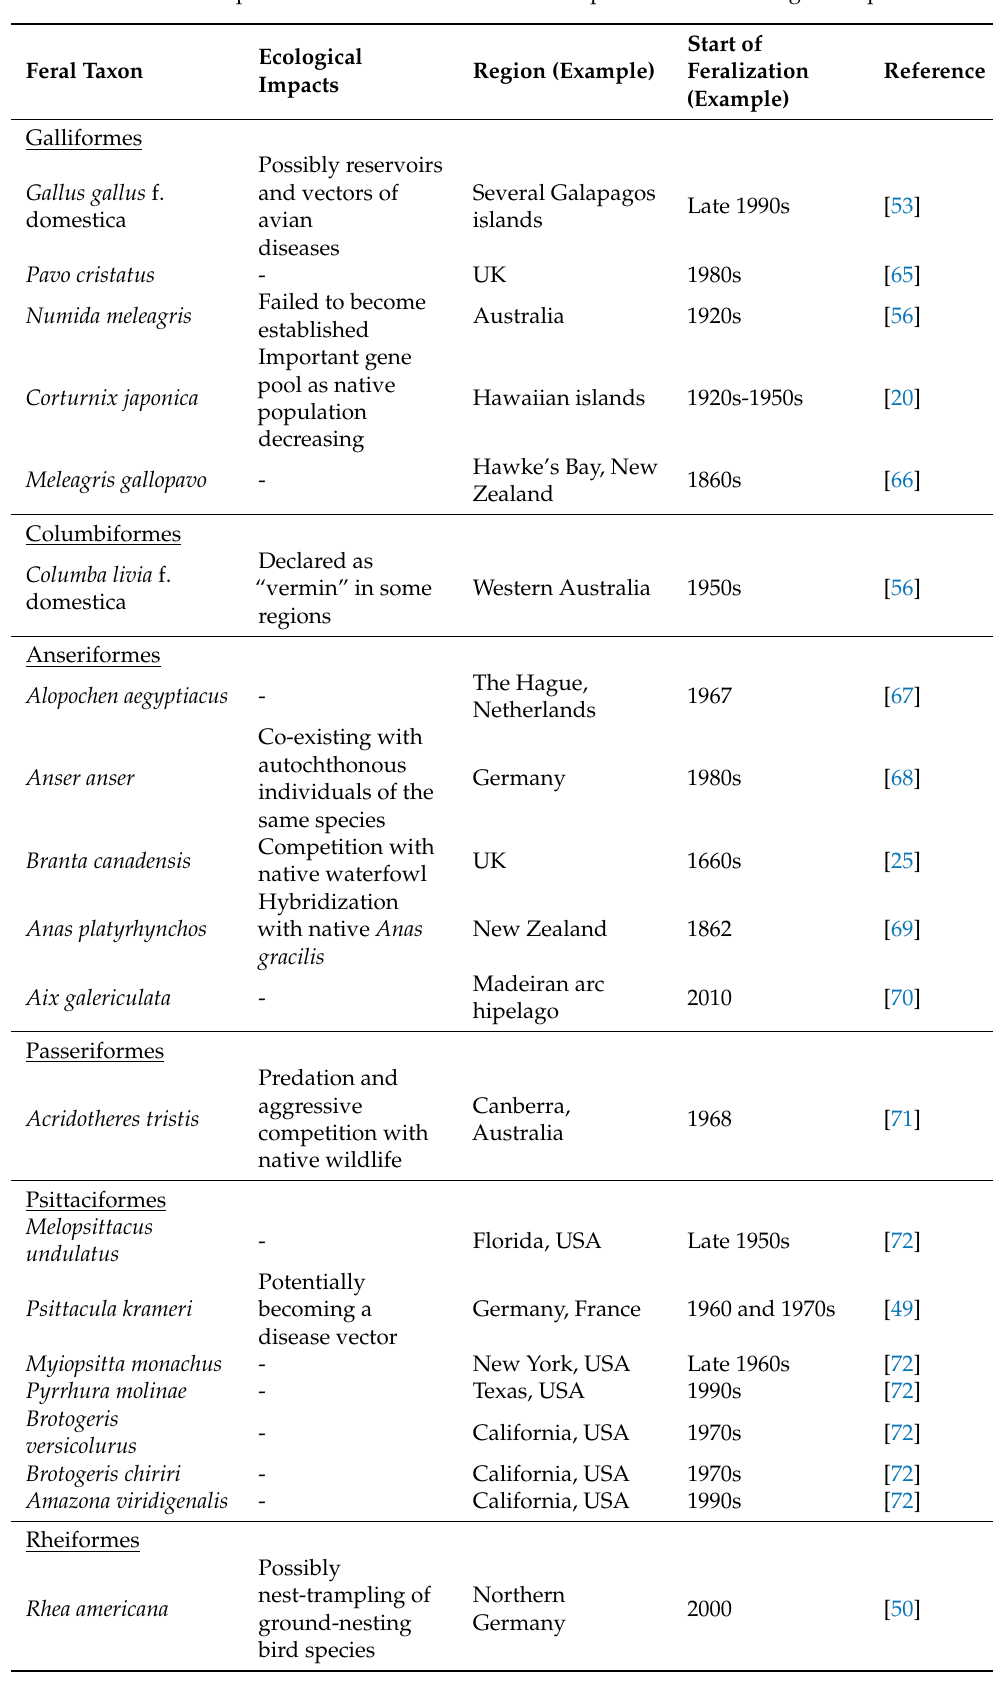
Table 2. Selected examples of feralization events of avian species and the ecological implications. Feral Taxon